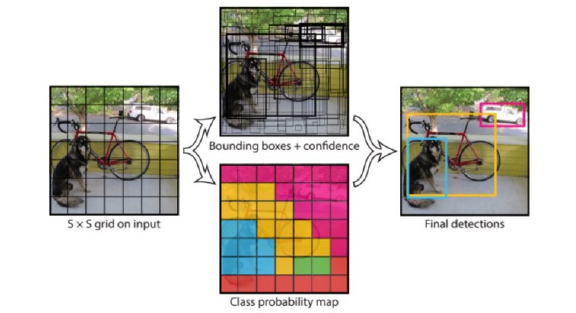
Figure 2: YOLO image processing overview (Redmon and Farhadi, 2017a)